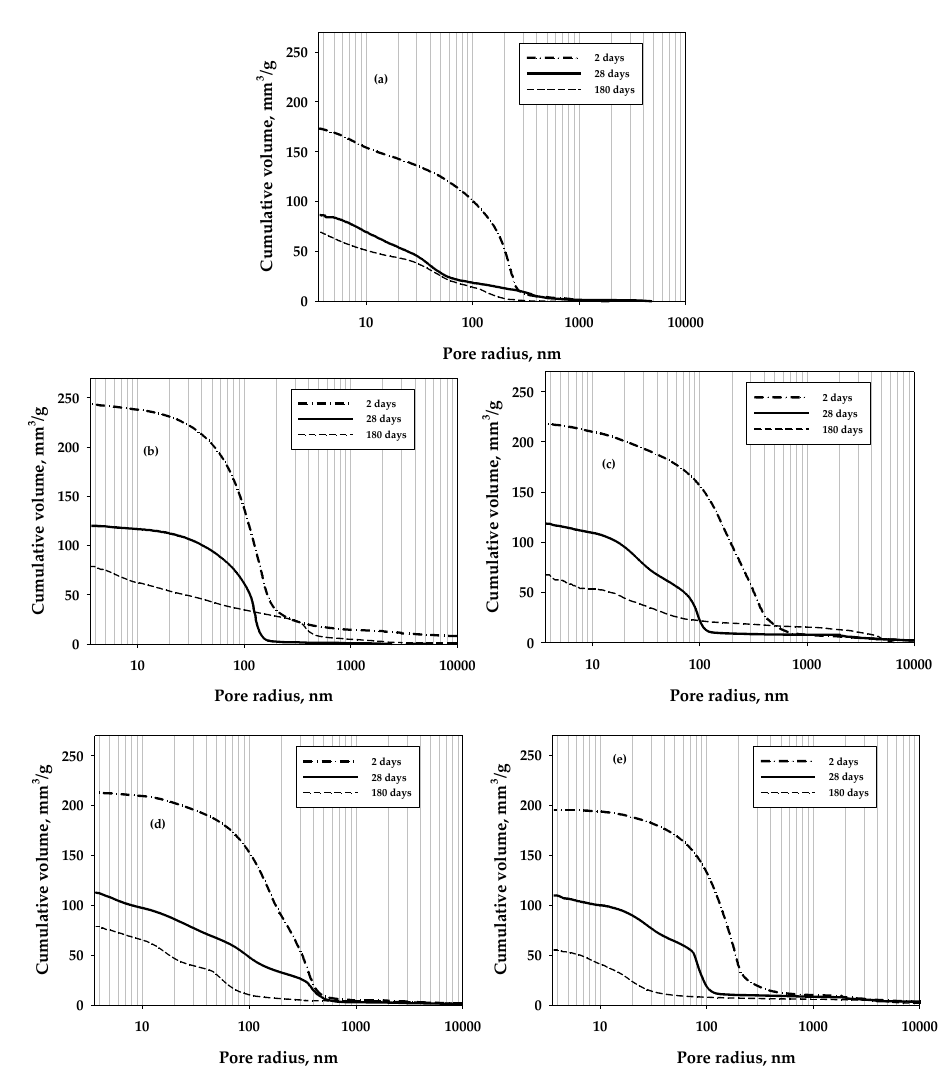
Figure 9. Cumulative Hg volume as a function of pore radius for C_R ( a ), C_AI ( b ), C_AC ( c ), C_BI ( d ) and C_BC ( e ) hydrated pastes (w/b = 0.5) at 2, 28 and 180 days.